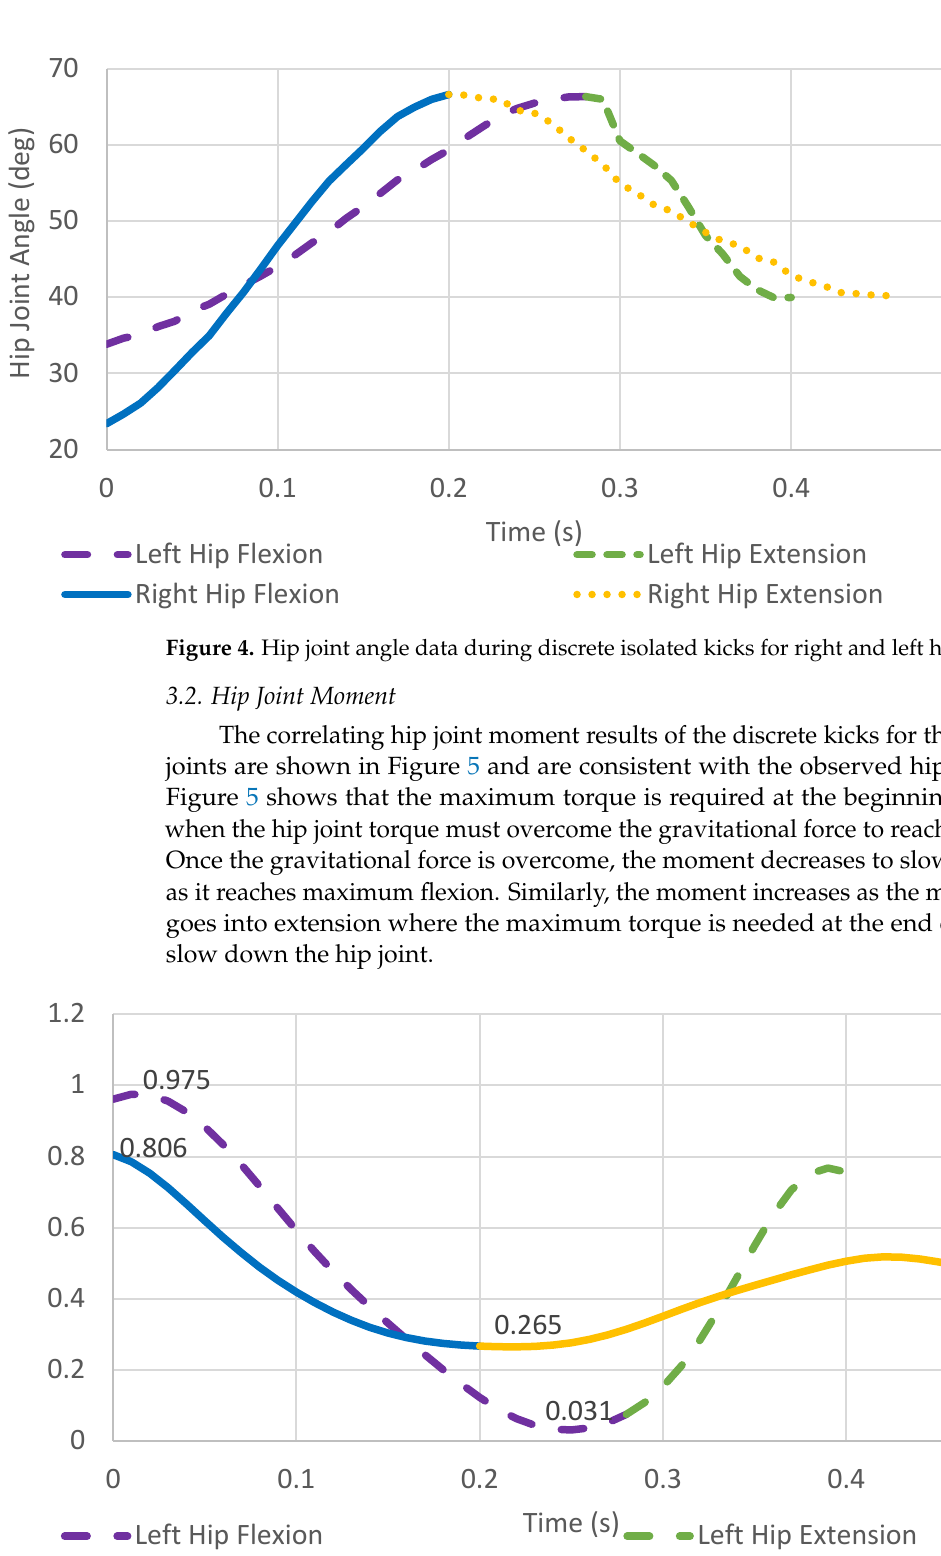
Figure 3. Hip joint ROM for left and right hips over a 3 s period.